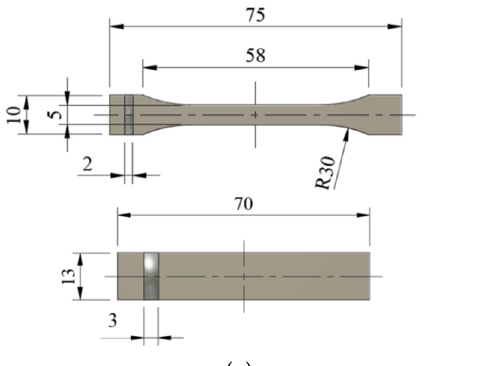
Figure 3. Representative images of the extruded filaments of the 3 mm group: ( a ) 2 wt.%, ( b ) 3.5 wt.%, and ( c ) 5 wt.%.